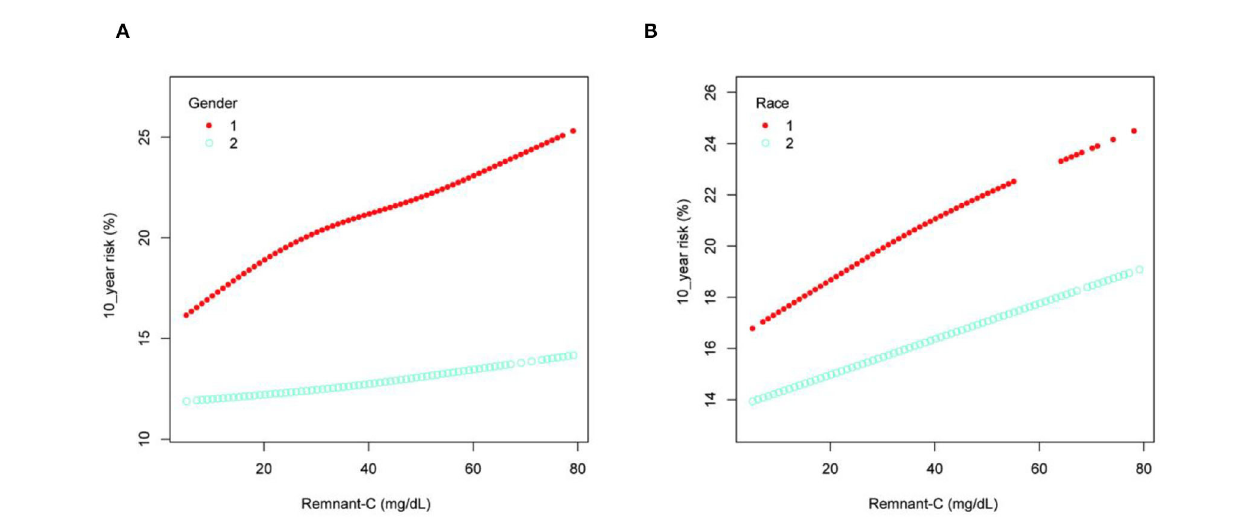
FIGURE 2 | Stratified association between Remnant-C and the 10-year risk of a first hard ASCVD event. (A) stratified by gender, 1 = Men, 2 = Women. (B) stratified by race, 1 = Non-Hispanic Black, 2 = Others. Gender, age, race, body mass index, systolic blood pressure, diastolic blood pressure, hypertension treatment, smoking, diabetes, and low-density lipoprotein cholesterol were adjusted. In the subgroup analysis stratified by gender or race, the model is not adjusted for the stratification variable itself. Remnant-C, remnant cholesterol.